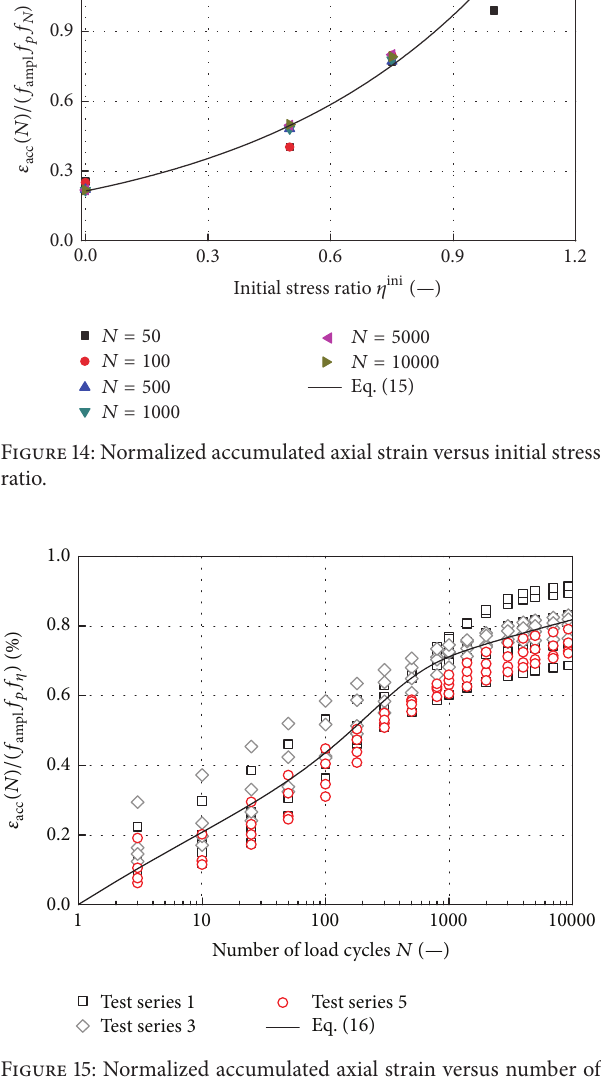
Figure 13: Normalized accumulated axial strain versus initial mean stress.